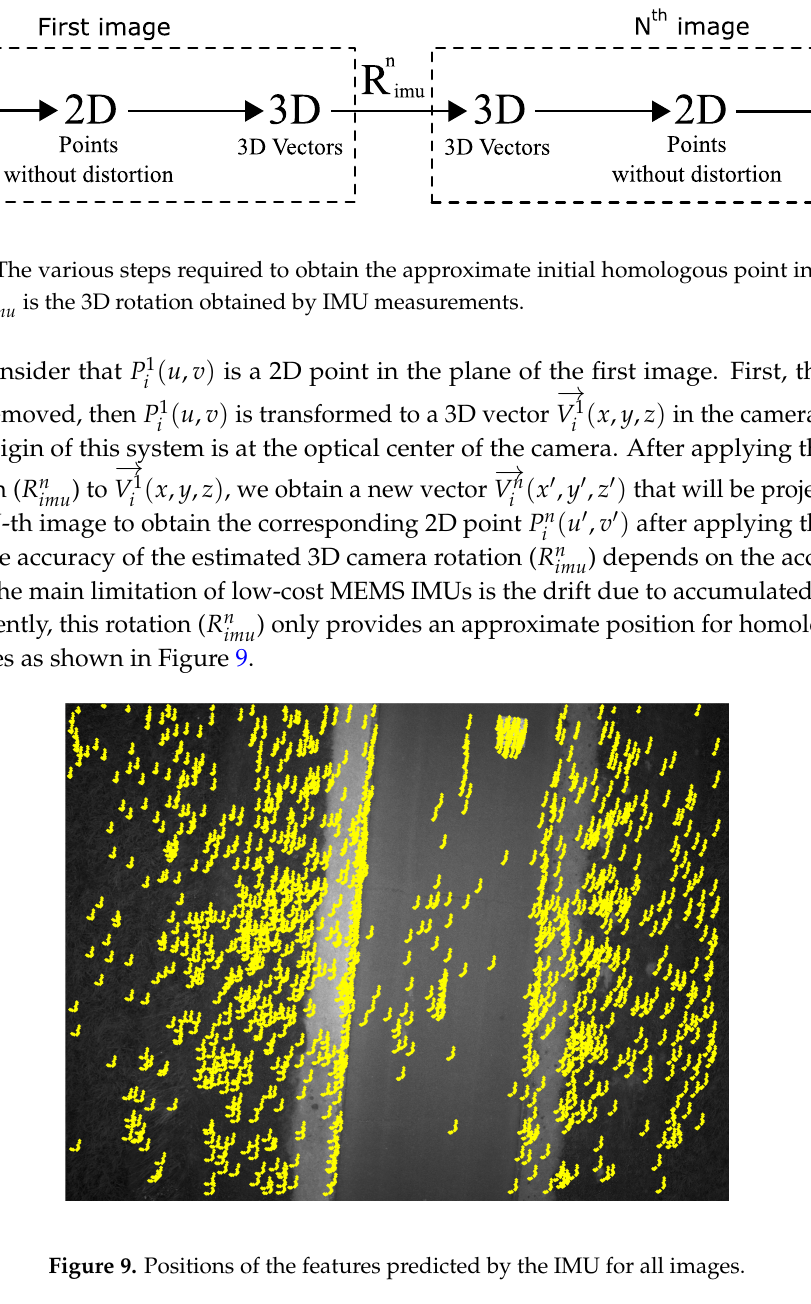
Figure 9. Positions of the features predicted by the IMU for all